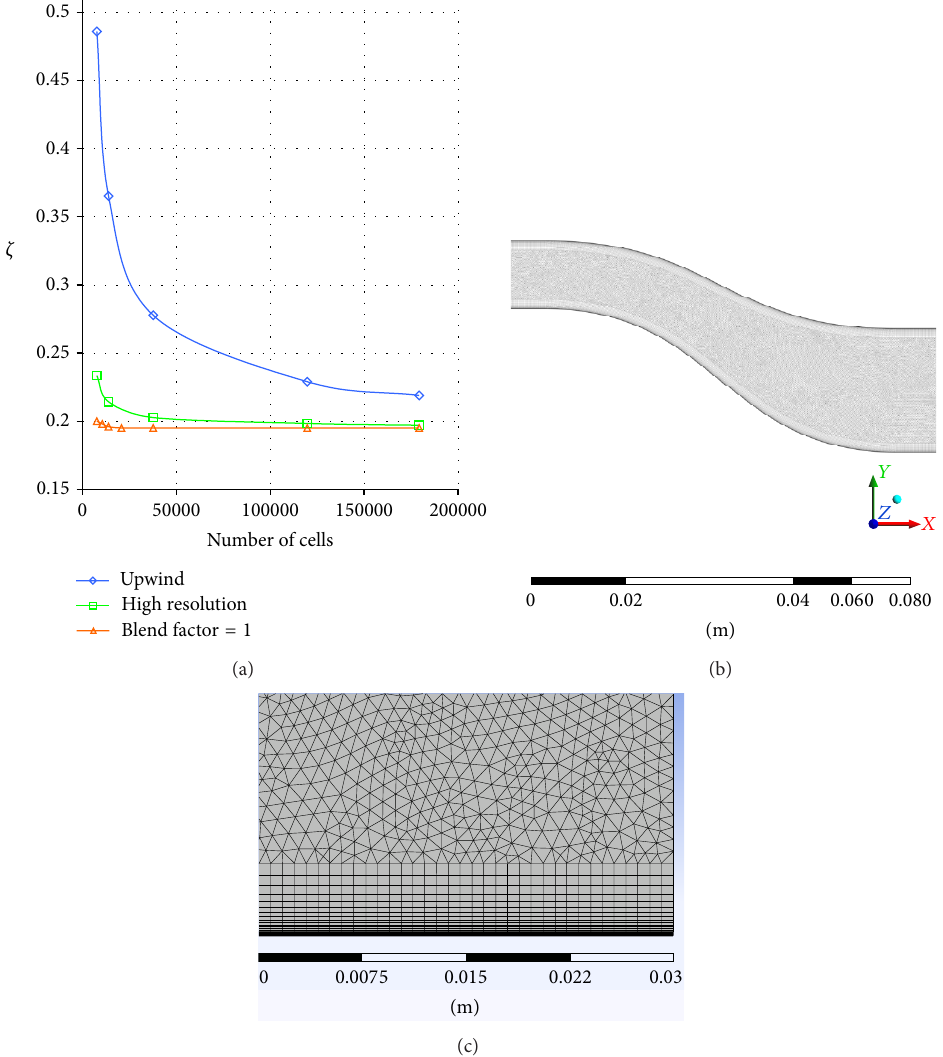
Figure 7: Annular duct mesh model: (a) grid convergence study, (b) CFD grid model, and (c) increased resolution of the grid at the exit.